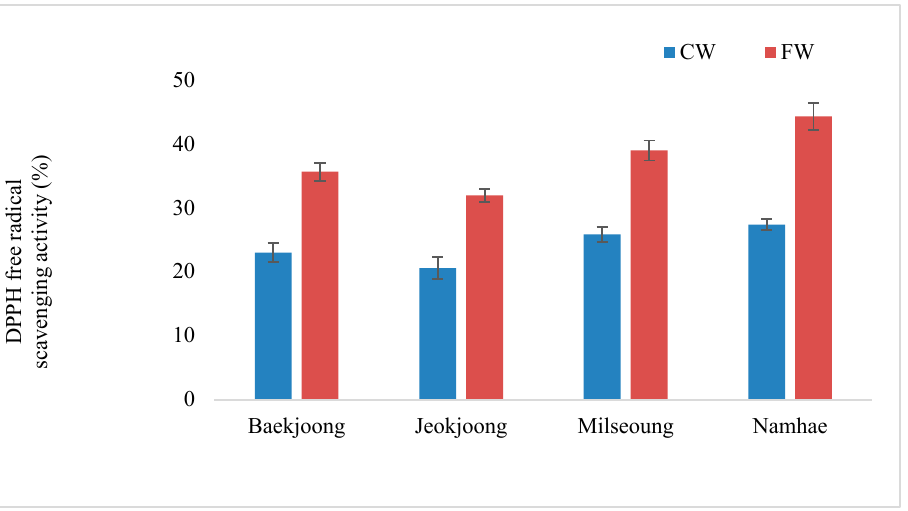
Figure 4. DPPH free radical scavenging activity of cooked wheat and fermented wheat. Error bars (mean ± SD) represent significant differences among the treatments. The data were analyzed with a one-way ANOVA followed by Duncan multiple range tests ( p < 0.05). CW: cooked wheat, FW: fermented wheat.